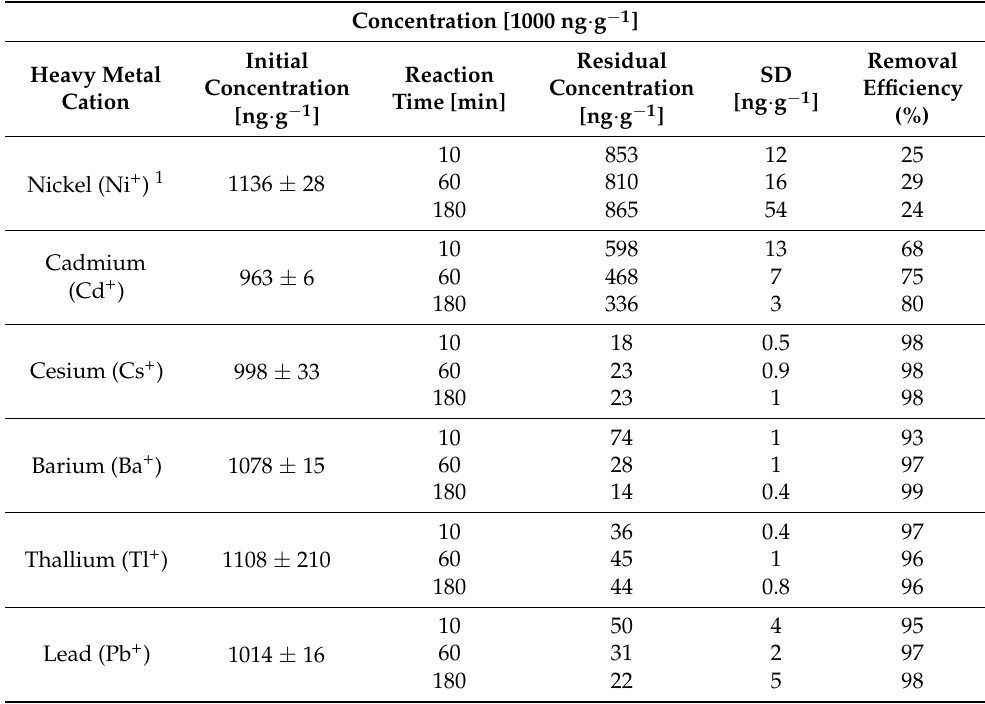
Table 4. Adsorption of studied heavy metal cations from single-element solutions with concentrations of 1000 ng · g − 1 onto PCT.